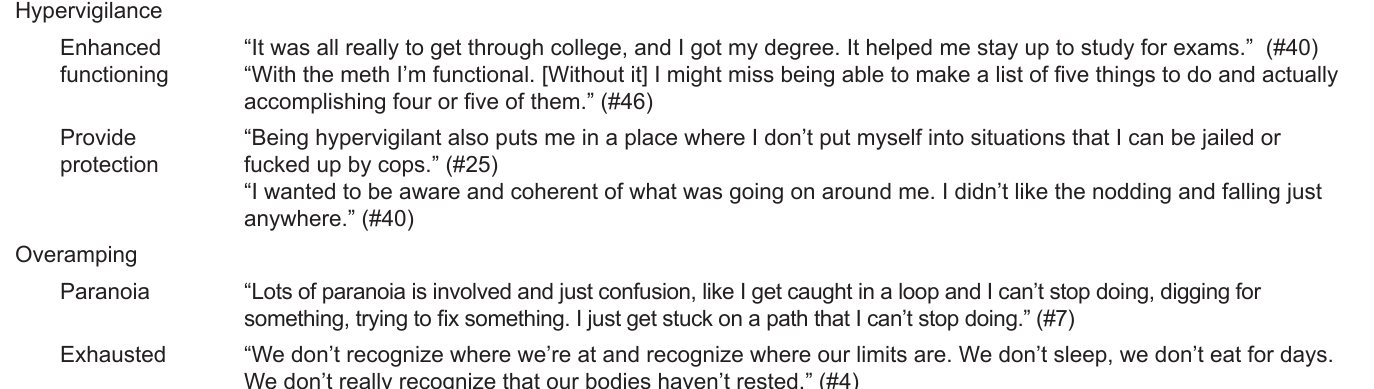
Table 3. Interviewee experiences that describe hypervigilance and overdosing (overamping).